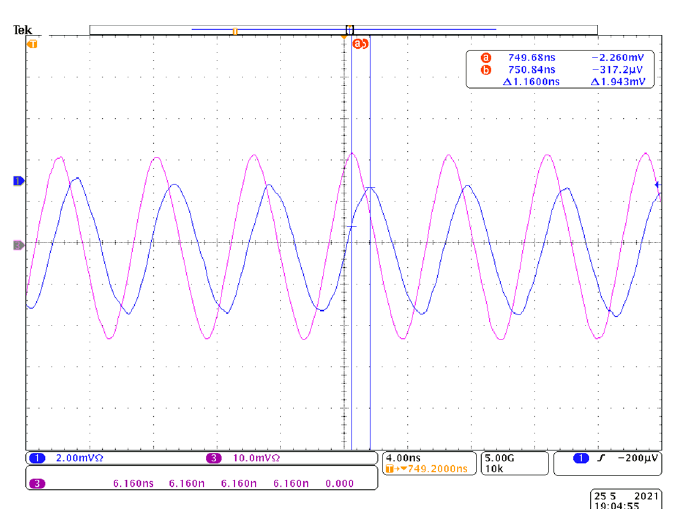
Figure 18. The beam signals detected by the two BPMs.